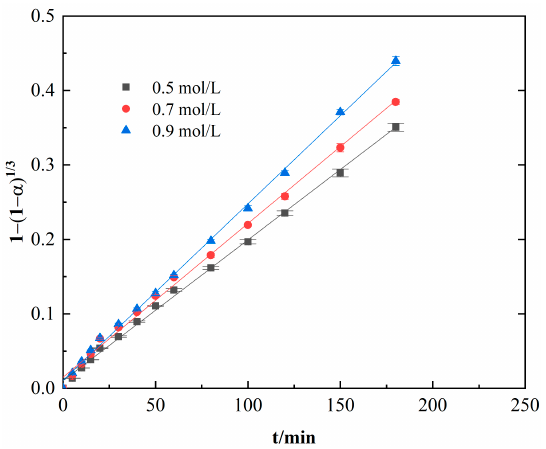
Figure 4. Relationship between 1 − (1 − 2 α /3) − (1 − α ) 2/3 and time at different temperatures. Figure 6. Effect of phosphate concentration on the leaching efficiency of tungsten.